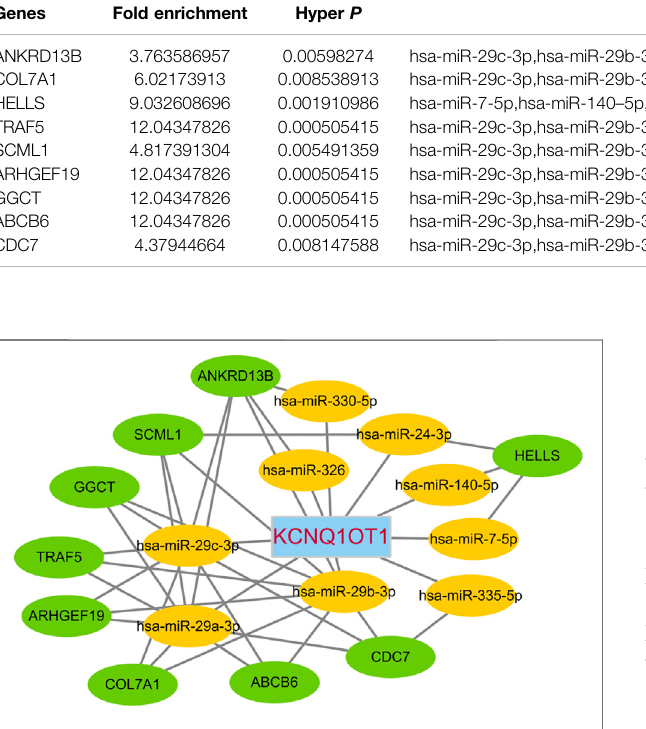
FIGURE 5 | KCNQ1OT1 ceRNA